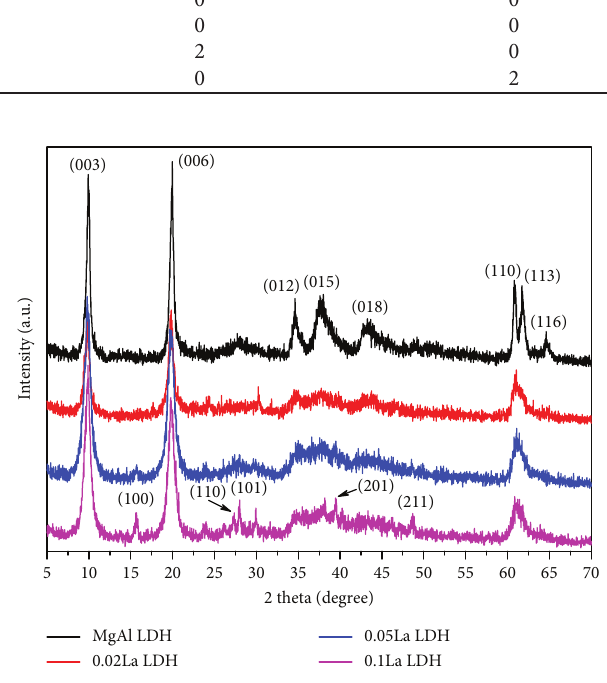
Figure 1: XRD spectra of MgAl LDH, 0.02 La LDH, 0.05 La LDH, and 0.1 La LDH.